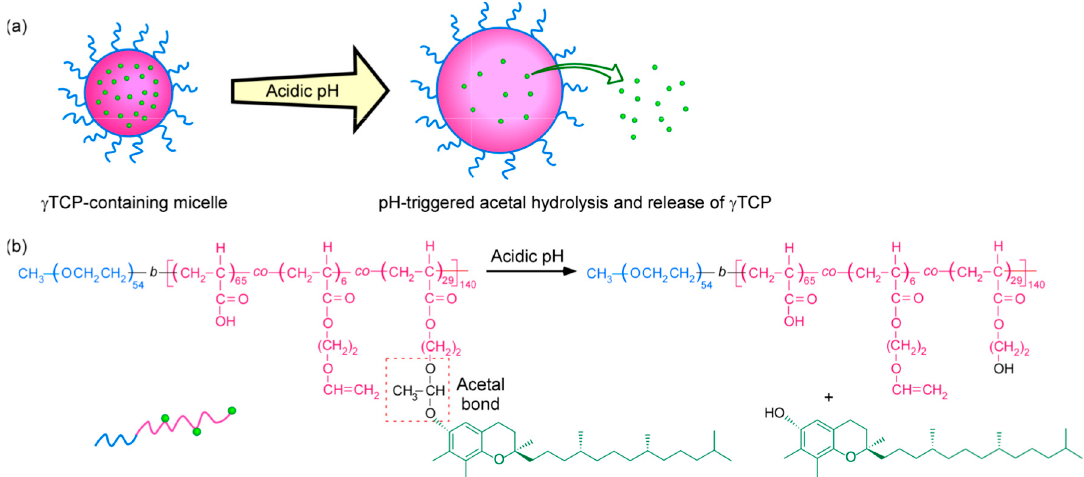
Figure 2. ( a ) Micelle formation and release of γ TCP in acidic aqueous solution; ( b ) chemical structure of PEG 54 -P(AA/VE6/ γ TCP29) 140 .